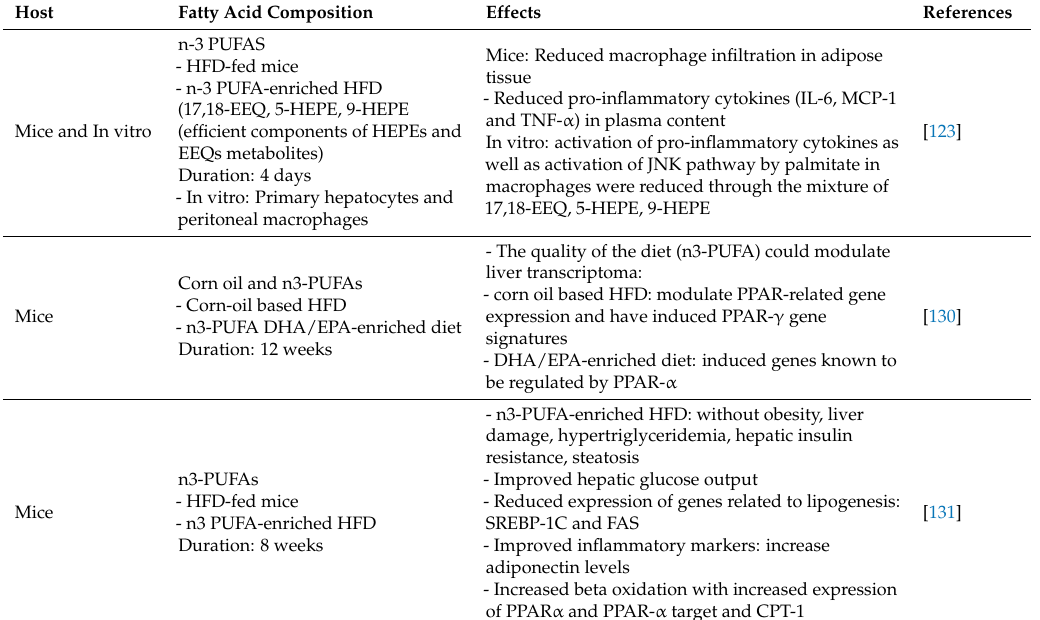
Table 8. The effects of dietary fatty acids in in vivo and in vitro models with non-alcoholic fatty liver disease